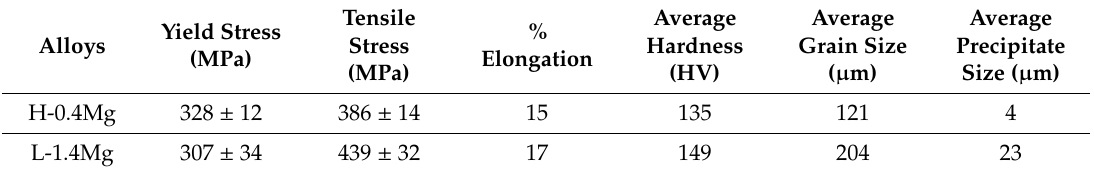
Table 2. Summary of the mechanical and microstructural properties at peak-aged state. Yield Alloys